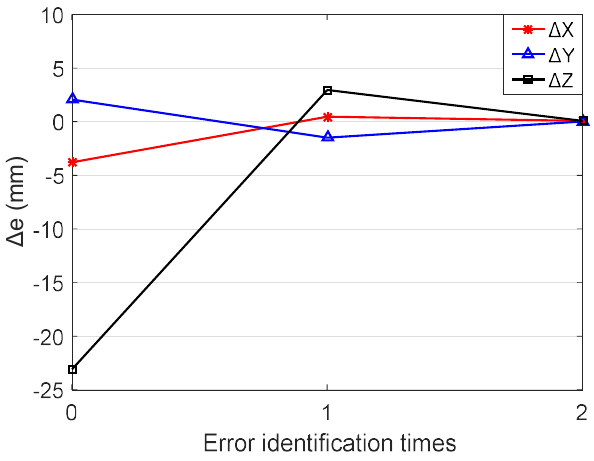
Figure 13. The relations between position errors and identification times. Table 7. The experimental results of kinematic calibration.